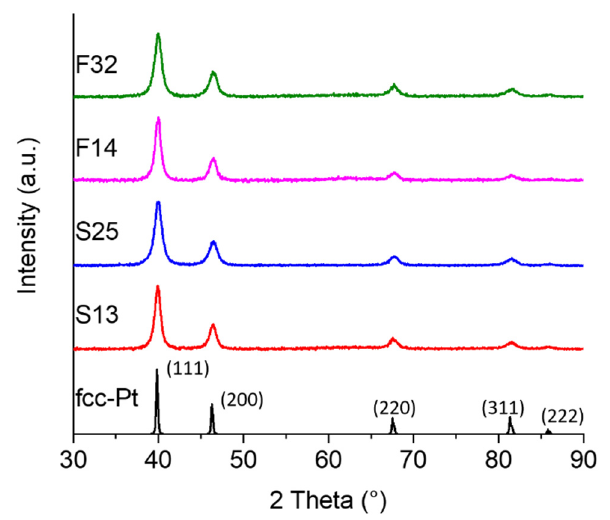
Figure 1. PXRD patterns of selected SC-Pt-NS samples and an fcc-Pt reference (crystallographic open database fcc-Pt: 1011114). The sample designations “S” and “F” indicate the carbohydrate sucrose and fructose, respectively, and the respective number refers to the rounded value of found Pt wt.% from AAS. See Figure S4 for the PXRD patterns of all samples and Table S2 for the average crystallite sizes of the individual samples.